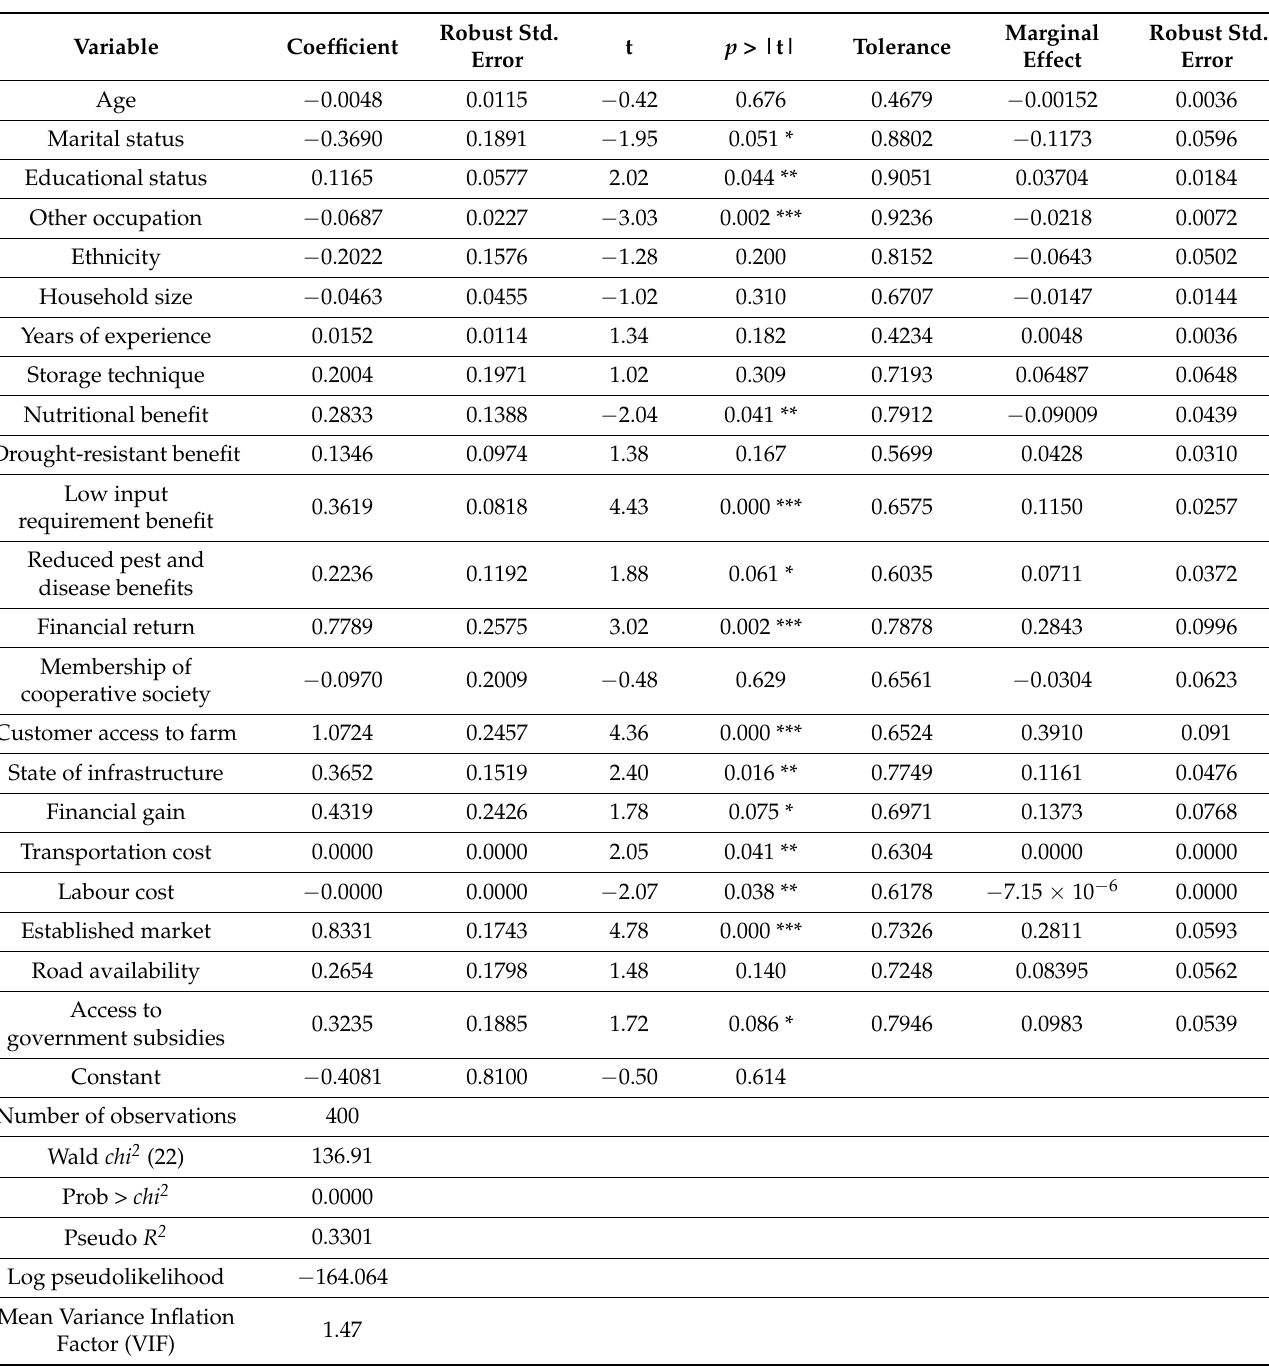
Table 5. Probit regression result of factors influencing the decision of participants to utilize their lands to cultivate indigenous fruits and